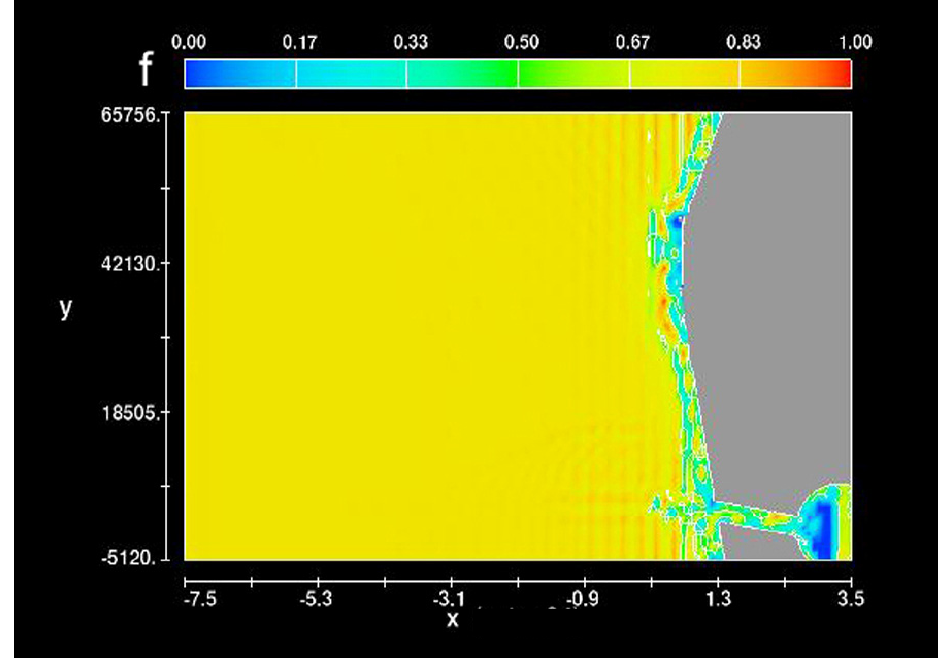
Figure 25. Flood slurry deposition: f = 1 is the ocean water, f = 0 is the flood slurry. Intermediate f values represent the slurry/ocean water mixture. Note the formation of a linear offshore beach ridge from the slurry deposition close to the shoreline as dependent on the ocean bottom slope. Length scale in km.